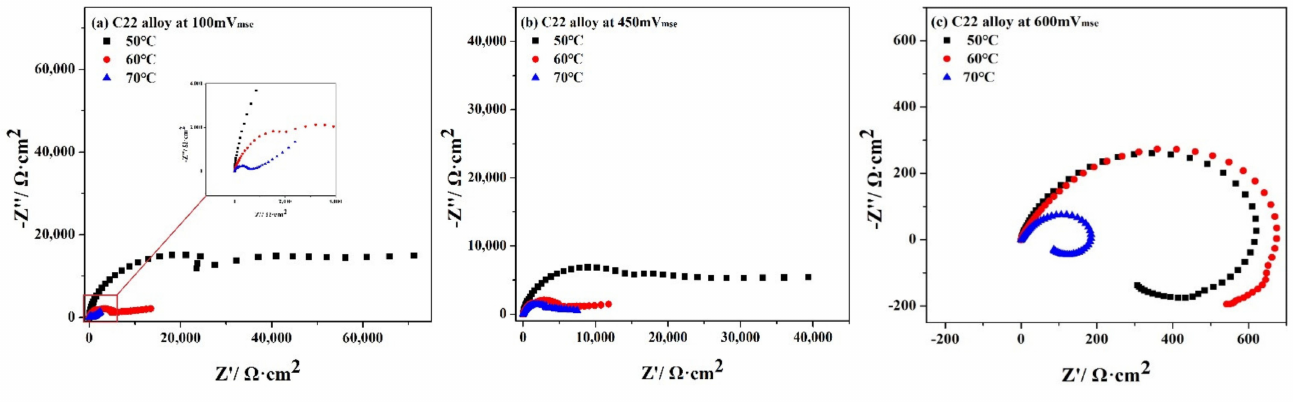
Figure 6. Nyquist plots for the C22 alloy in 50 wt.% H 2 SO 4 at 100 mV mse ( a ), 450 mV mse ( b ) and 600 mV mse ( c ).